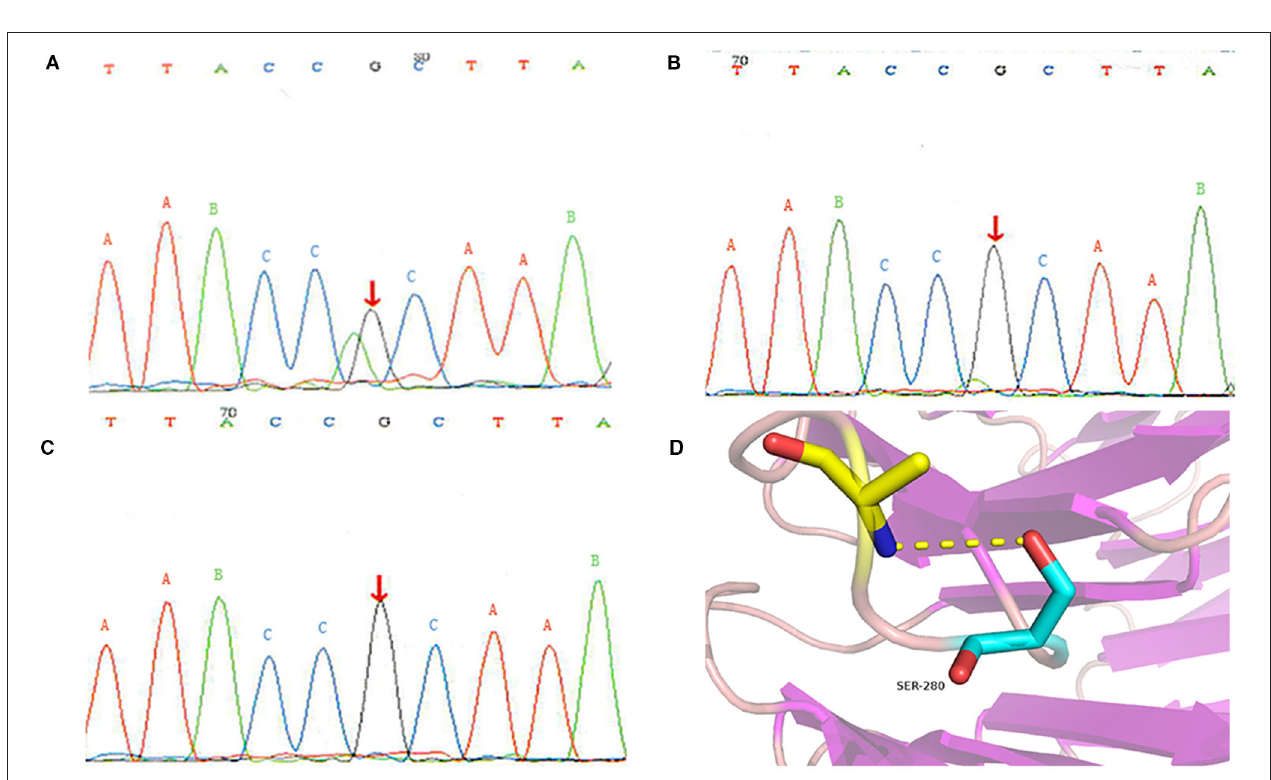
FIGURE 2 | Genetic analysis results: (A) heterozygous mutation of COPA gene in the patient; (B) there was no mutation in the COPA gene of his father; (C) there was no mutation in the COPA gene of his mother; (D) Protein conformation after amino acid mutation. The different uppercase letters represent base pairs, arrows A, B and C represent the 841st base, mutation occurs at site A, and no mutation occurs at site B and C.